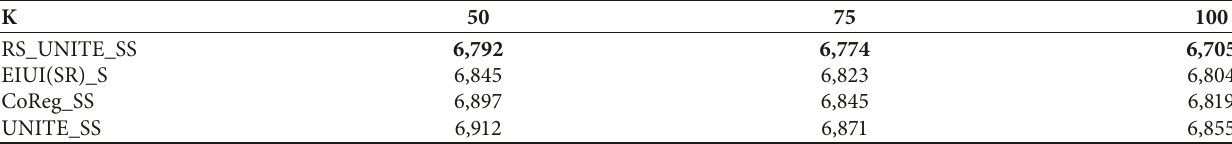
Table 5: Comparison of perplexity metrics on SubGraphdata.